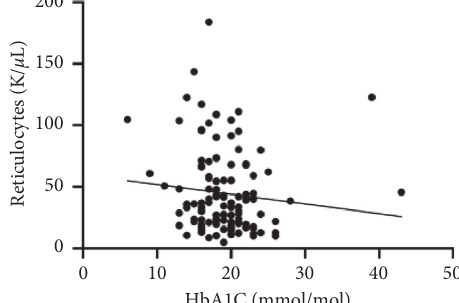
Figure 6: Relation between the reticulocyte number and HbA1c ( r � 0.011; p � 0 .